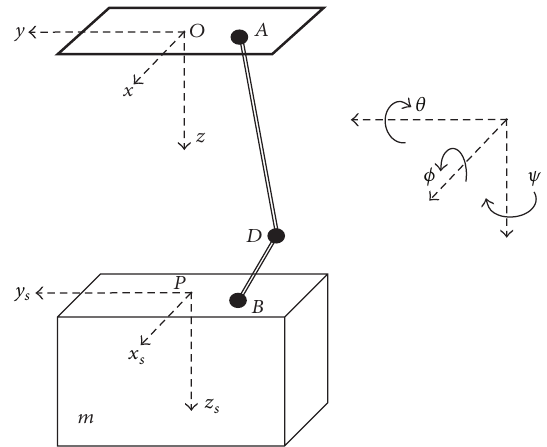
Figure 13: Two general links connect the trolley and the spreader and three Euler